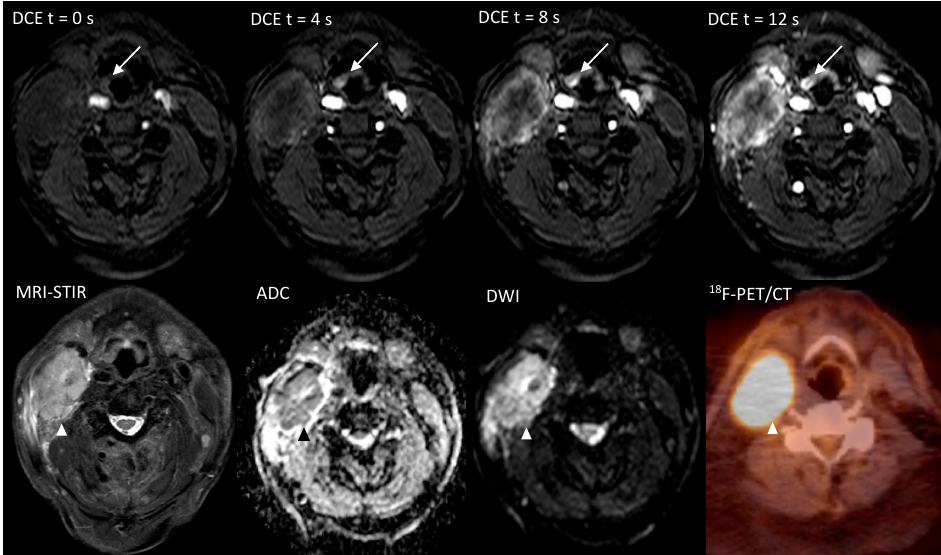
Figure 1. Imaging of a 71-year-old patient, with a hypopharyngeal (epiglottal) primary tumor detected only on the ultrafast-DCE imaging (arrow), whereas DWI and 18 F-FDG-PET/CT did not detect the lesion. The overt malignant lymph node metastasis is marked with an arrowhead ( Δ ). In the per-patient (Table 4; II and III) analysis with a co-detection (positive read) on all combined modalities, a 95% (95%CI = 75.1–99.9%) sensitivity for DWI + PET, was non-significantly higher than DWI + DCE (sensitivity = 90% (95%CI = 68.3–98.8%, p = 0.32) and DWI + DCE + PET (sensitivity = 90% (95%CI = 68.3–98.8%, p = 1.0). In this analysis, the specificity of 55.6% (95%CI = 21.2–86.3) for DWI + DCE + PET was higher than DWI + ultrafast-DCE (specificity = 44.4%, 95%CI = 13.7–78.8%, p = 0.63) and DWI + 18 F-FDG-PET/CT (specificity = 33.3%, 95%CI = 7.5–70.1%, p = 1.0).